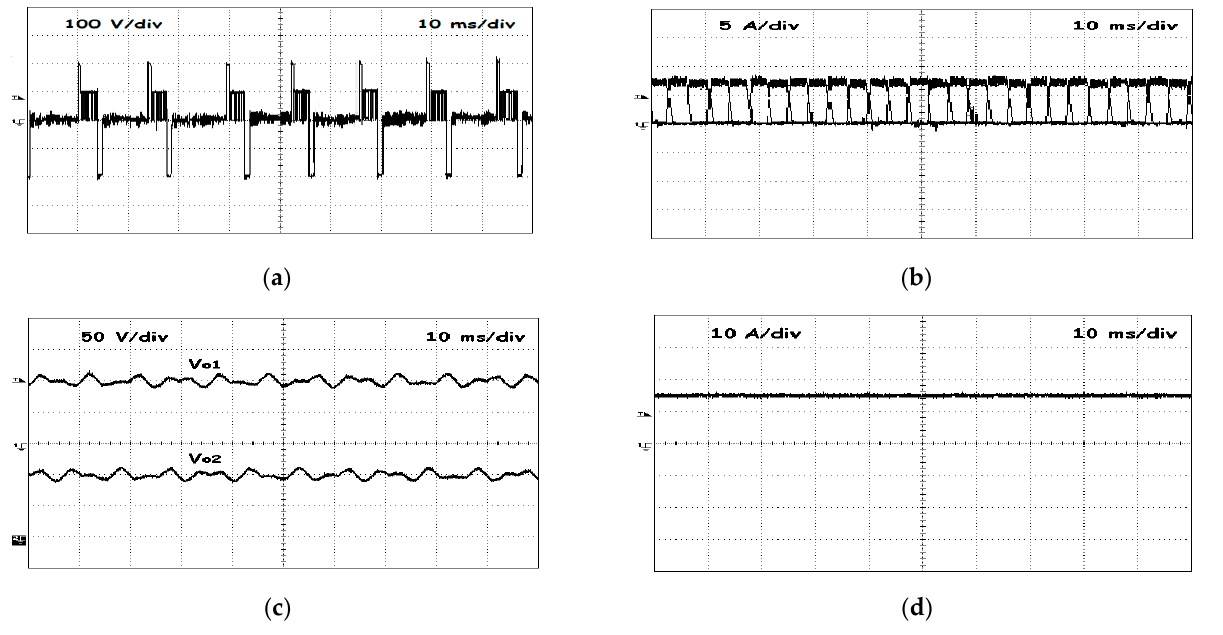
Figure 12. Obtained experimental waveforms for the tests in which 700 W/m 2 (irradiance) and 25 °C (ambient temperature) associated with the motor drive were defined: ( a ) voltage applied to motor winding A , ( b ) currents in all motor windings, ( c ) input DC voltages applied to the drive, ( d ) converter input current.